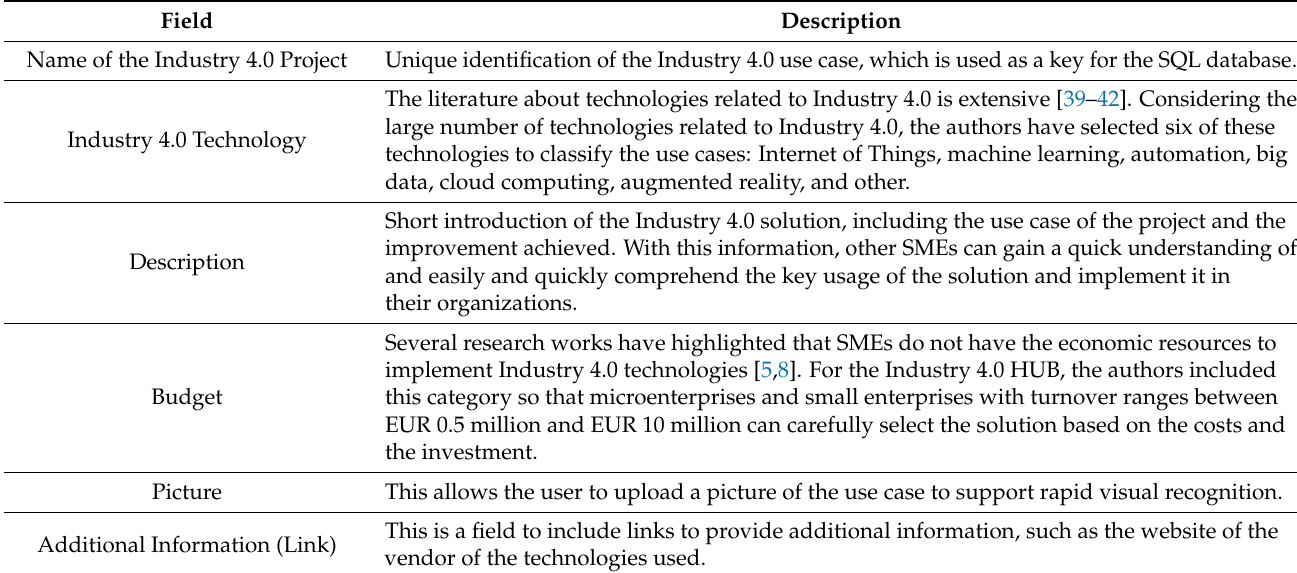
Table 1. Dataset of the Industry 4.0 use cases.